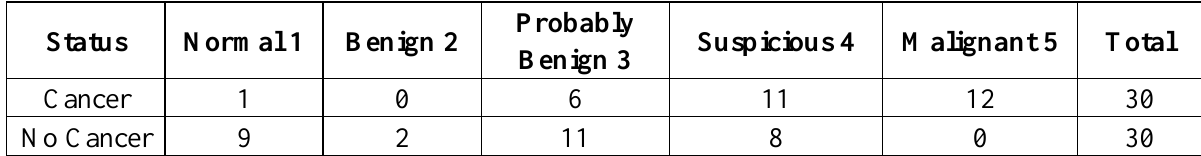
Table 6. Mammogram